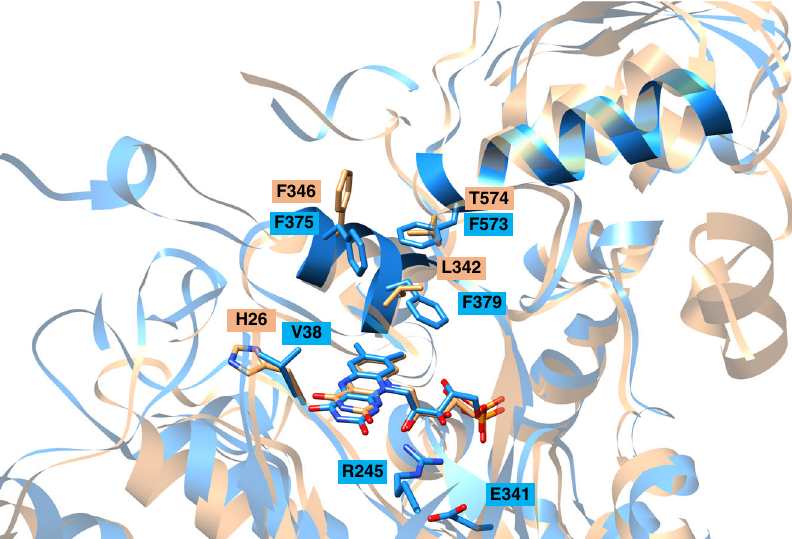
Fig. 4 Binding of the active site FMN cofactor. Overlay of NCR (blue) and DCR (amber). The FMN is shielded from bulk solvent by the two highlighted helices 371:380 and 572:585 that harbor F375, F379, and F573 creating a hydrophobic pocket absent in other OYEs. The hydride-donating N5 of the FMN is in close proximity of H26 in DCR, which is replaced by a hydrophobic V38 in NCR